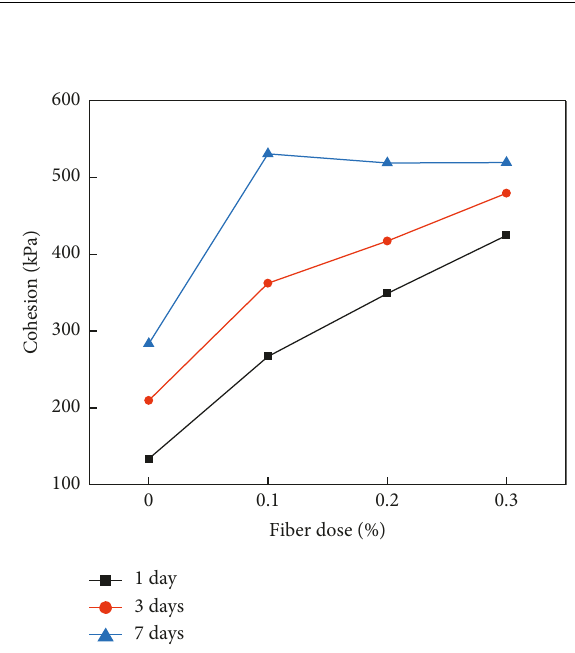
Figure 2: Variation of cohesion of cured remolded soils with fiber admixture at different curing times.